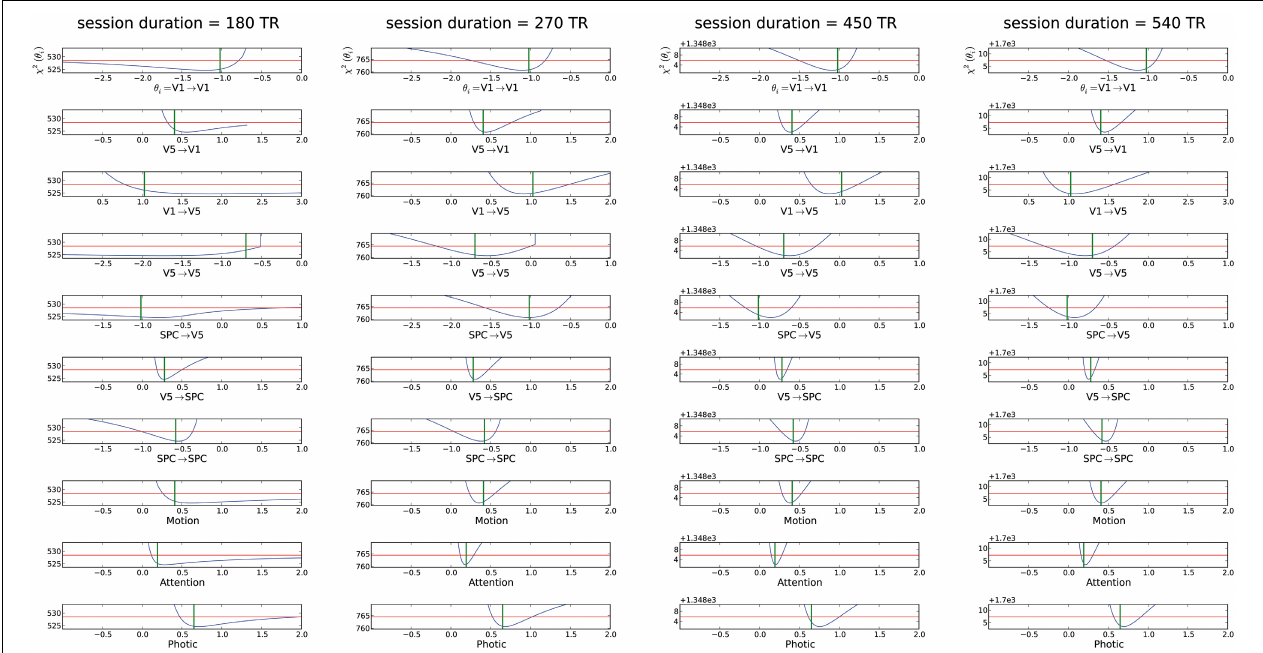
FIGURE 3 | Assessment of different session durations ranging from 180 to 540 times the original TR for the “forward model.” For explanation of the graphs see Figure 2 . The mCI were from left to right ∞ , 0.58, 0.38, 0.40.